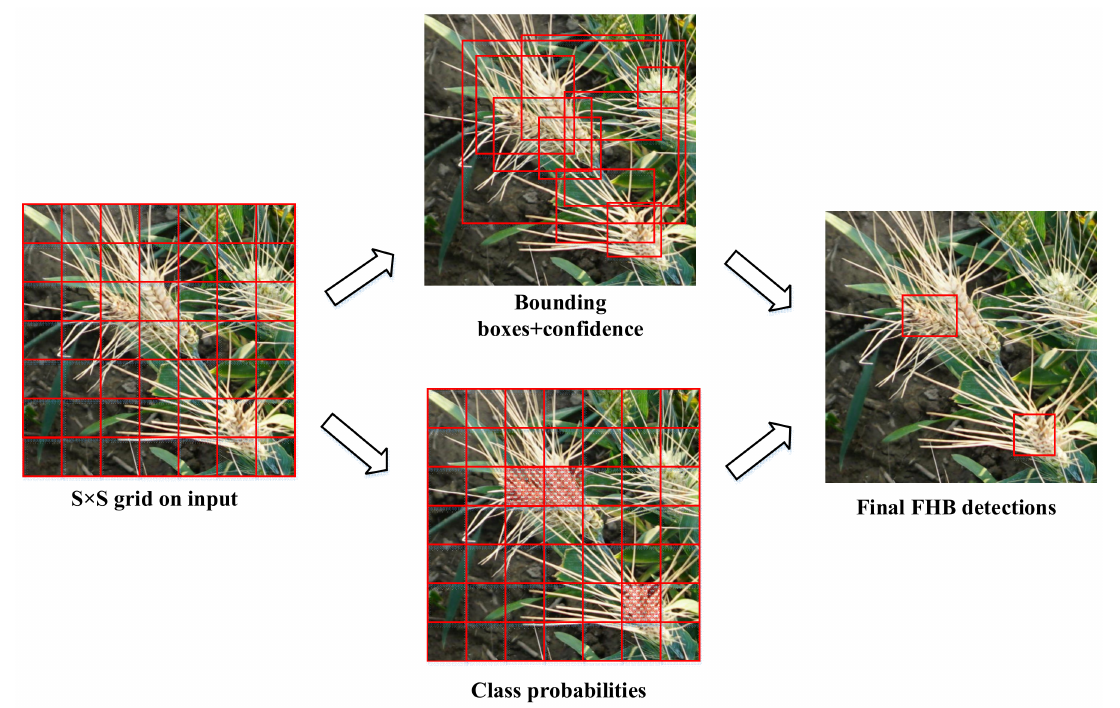
Figure 4. YOLO detection (YOLO algorithm models detection as a regression problem. It divides the image into an S × S grid and for each grid cell predicts bounding boxes, confidence for those boxes and class probabilities).